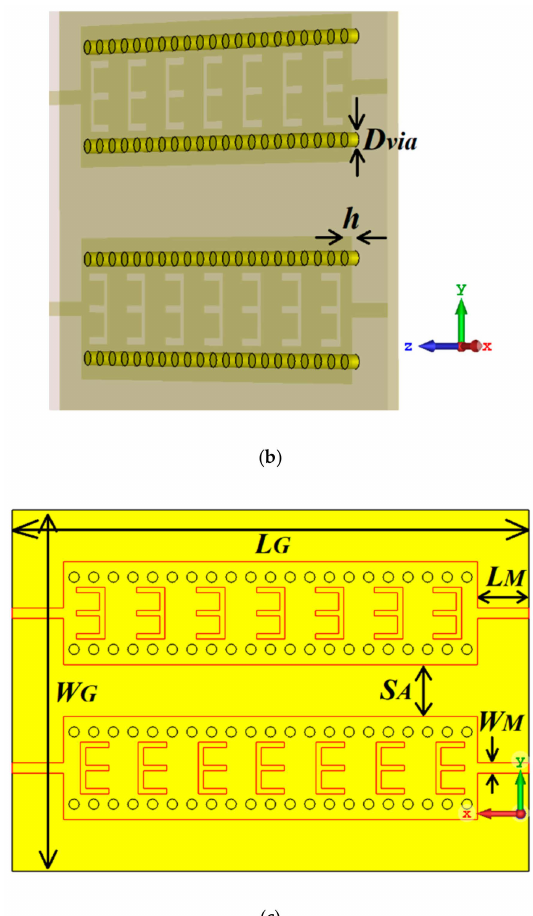
Figure 1. Proposed 1 × 2 array antenna based on MTM-LWA using SIW technology. ( a ) Top view; ( b ) view to show the Substrate integrated waveguide slots; ( c ) back side to show the ground plane.